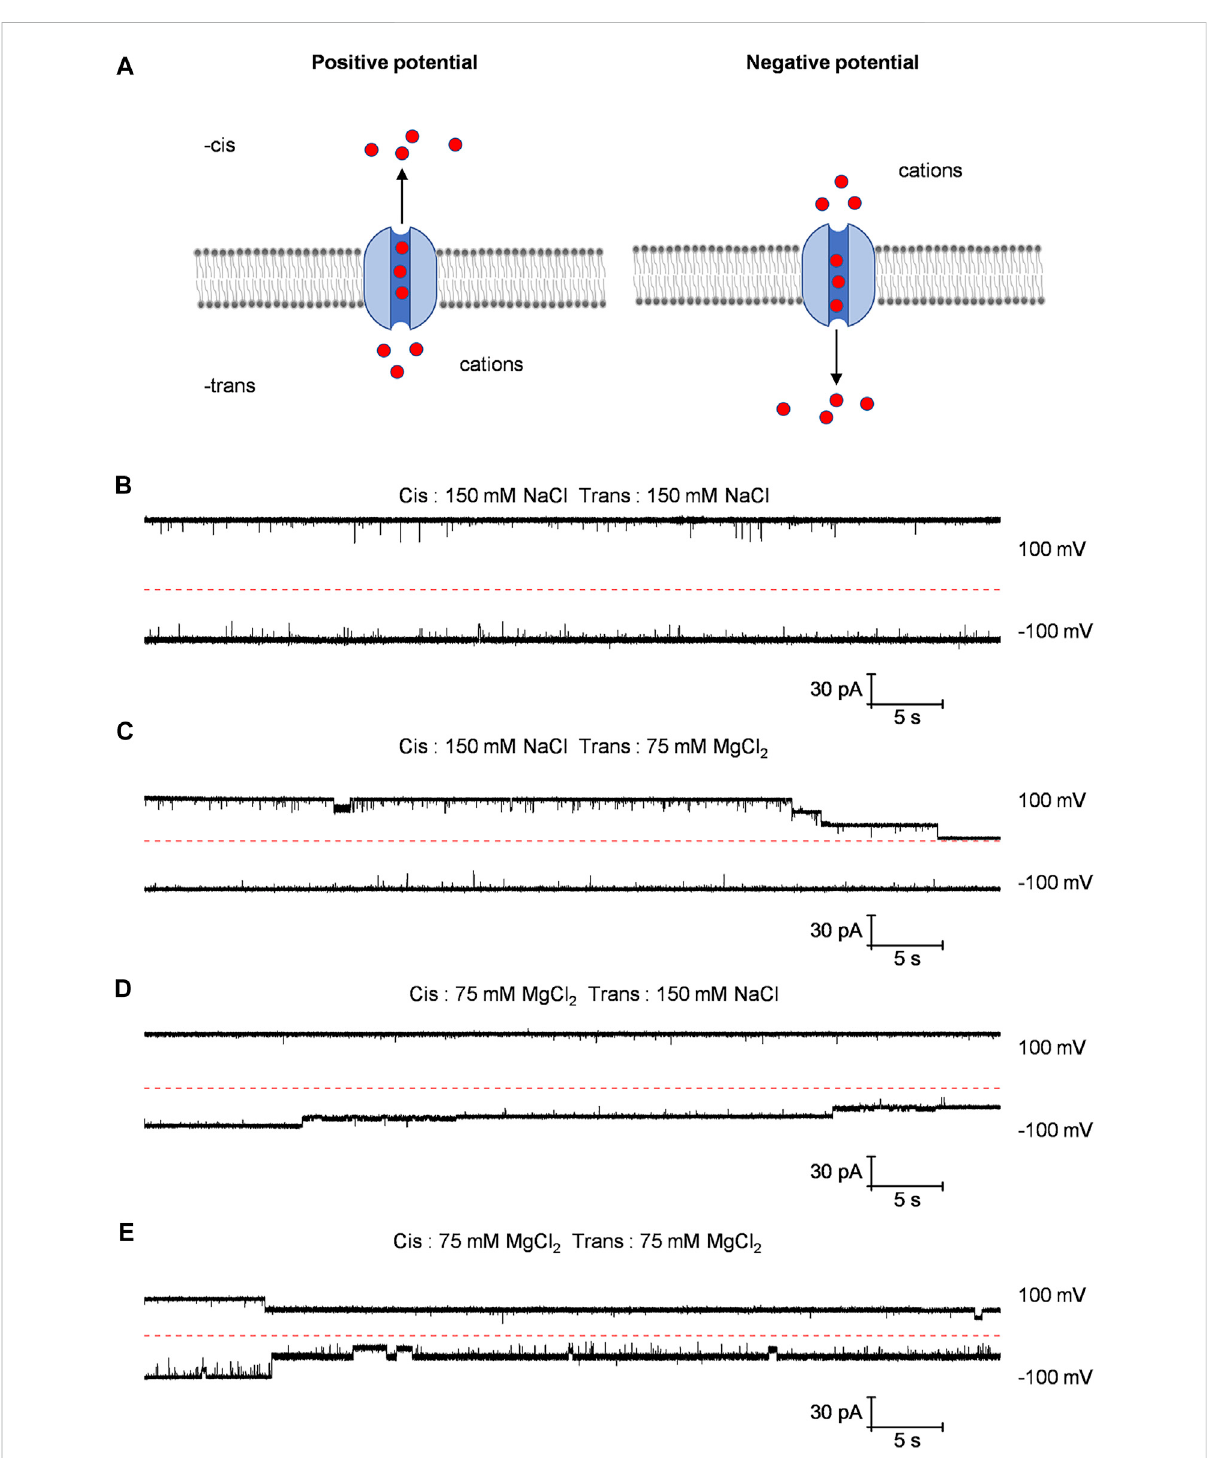
FIGURE 5 Different current traces of Bpss1228 channel under varied buffer conditions. (A) Schematic diagram of cations passing through the CorA channel when different voltages are applied. (B – E) The represent current traces at 100 mV and − 100 mV in different buffer conditions as indicated. All buffered 10 mM HEPES, pH